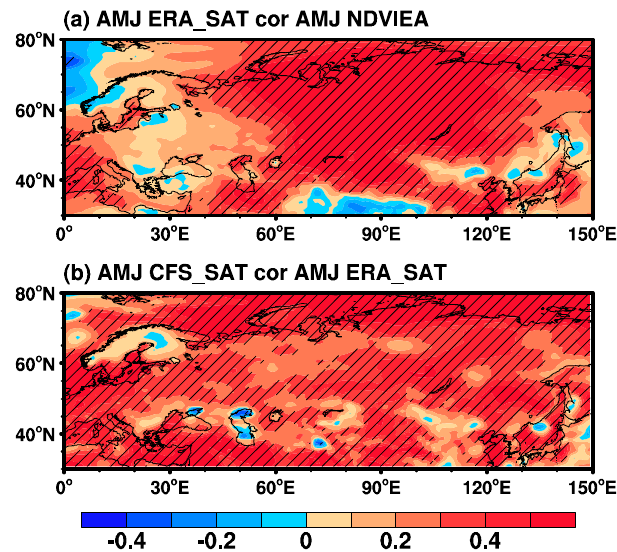
Figure 3. ( a ) Correlation between area-averaged spring (April–May–June (AMJ)) NDVIEA index and the surface air temperature (SAT) from ERA-Interim during 1982–2015. ( b ) Correlation between the spring SAT from ERA-Interim and CFSv2 during 1982–2015. Regions marked by slashes are significant ( α = 0.10; t -test).